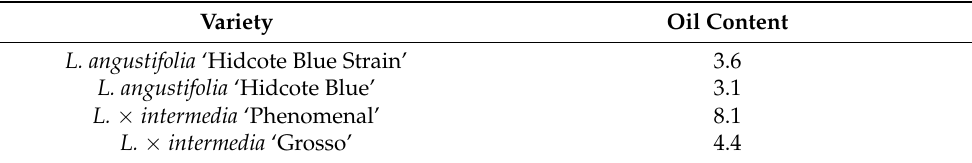
Table 1. The oil content of the dried plant material (% v / w